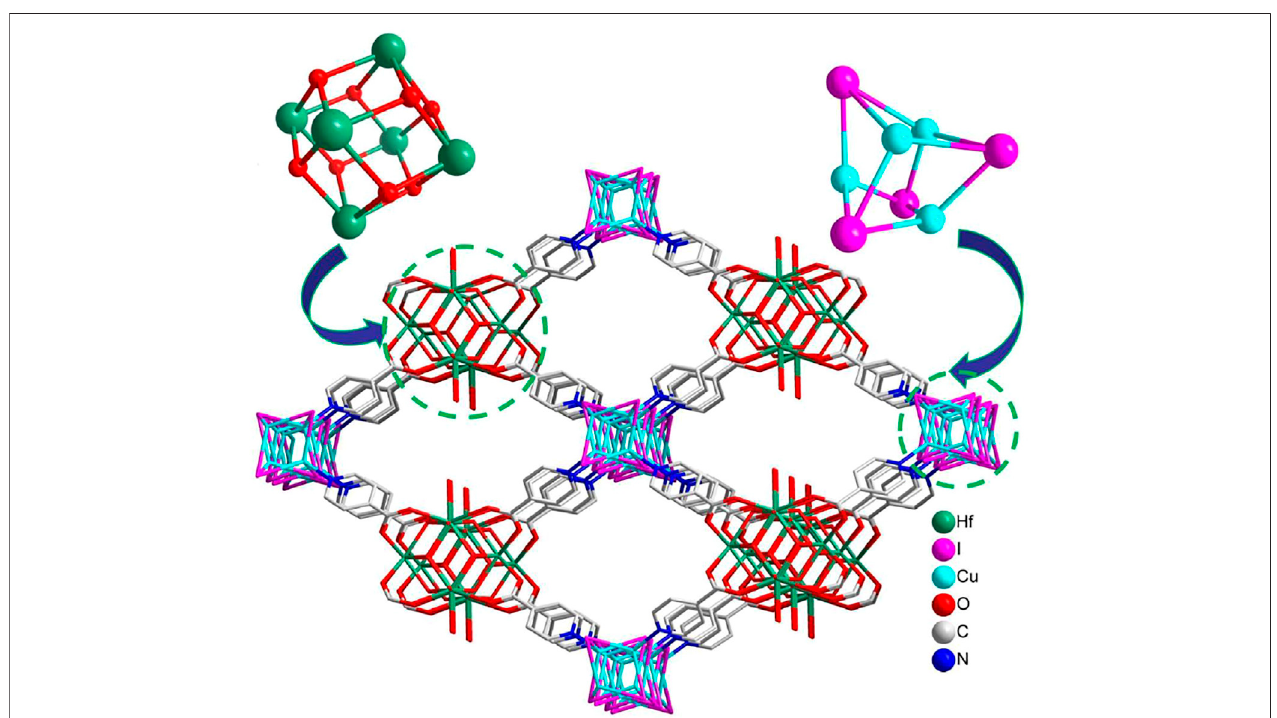
FIGURE 1 | Three-dimensional network of NS-1 ; all hydrogen atoms were omitted for